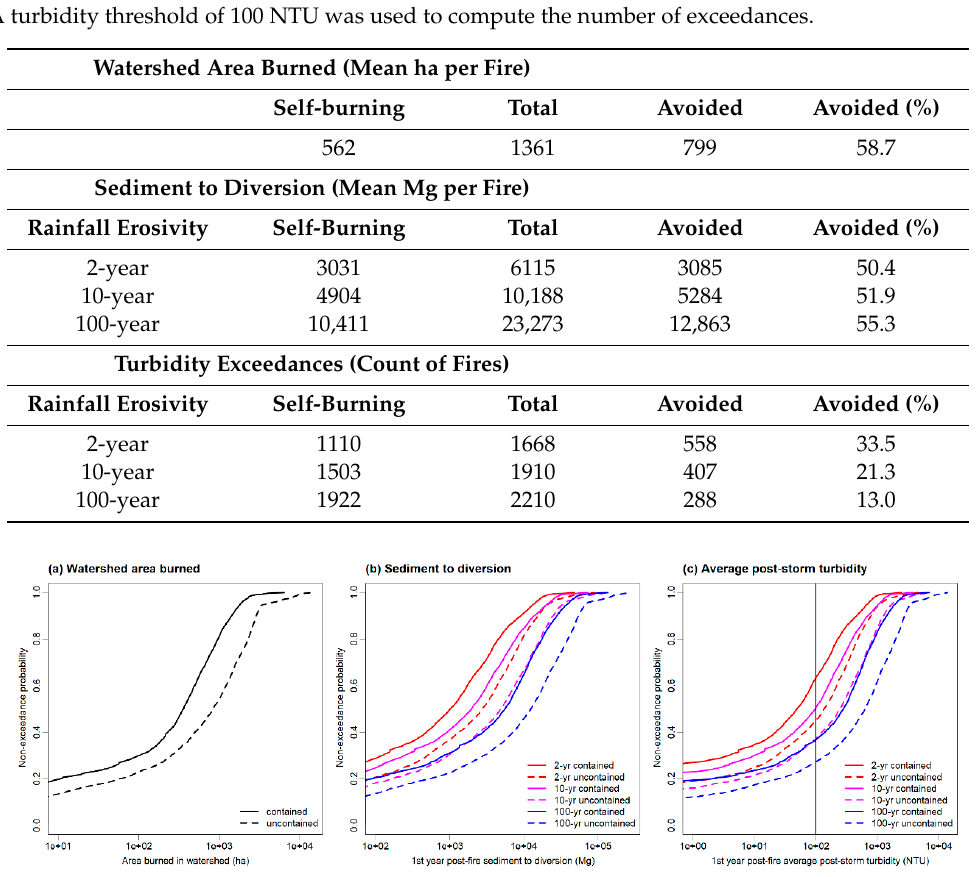
Figure 5. Summary of containment effects on distribution of fire-level indicators of water supply risk by rainfall erosivity including: ( a ) watershed area burned, ( b ) first-year post-fire sediment to the diversion, and ( c ) first-year post-fire average post-storm turbidity (vertical black line marks the 100 NTU threshold for treatment).